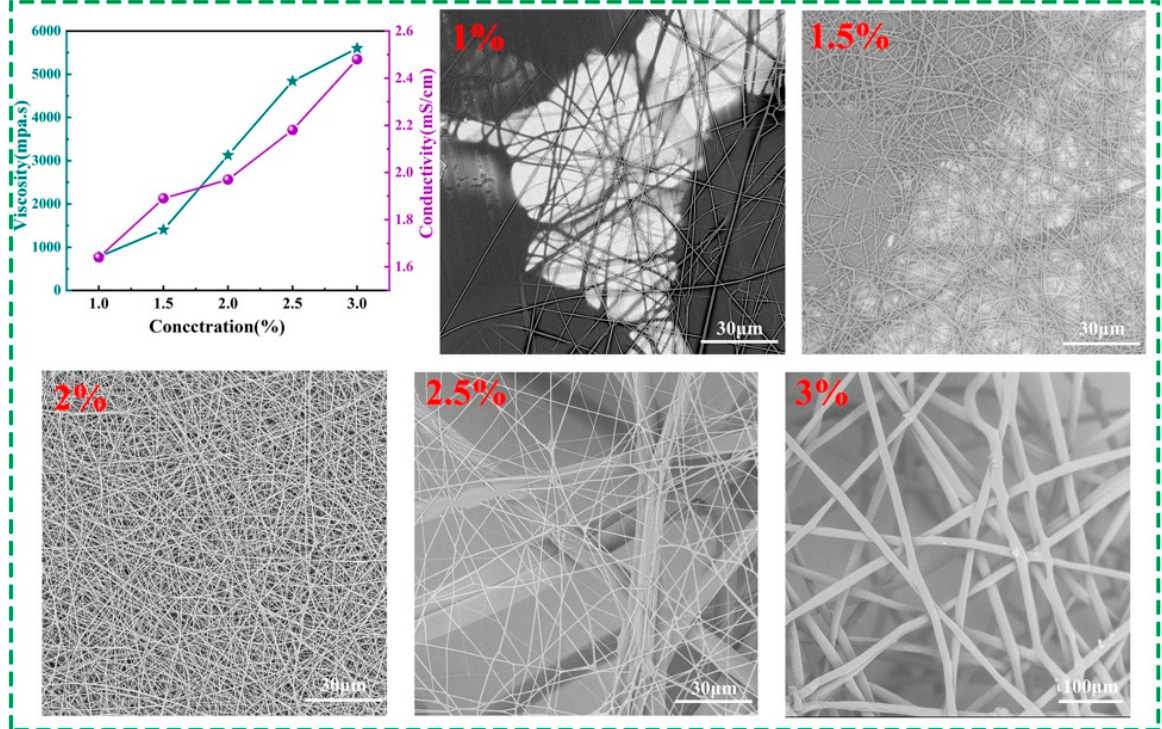
Figure 3. Spinning solution viscosity and conductivity at different concentrations, and the corre- sponding SEM images of nanofibers.